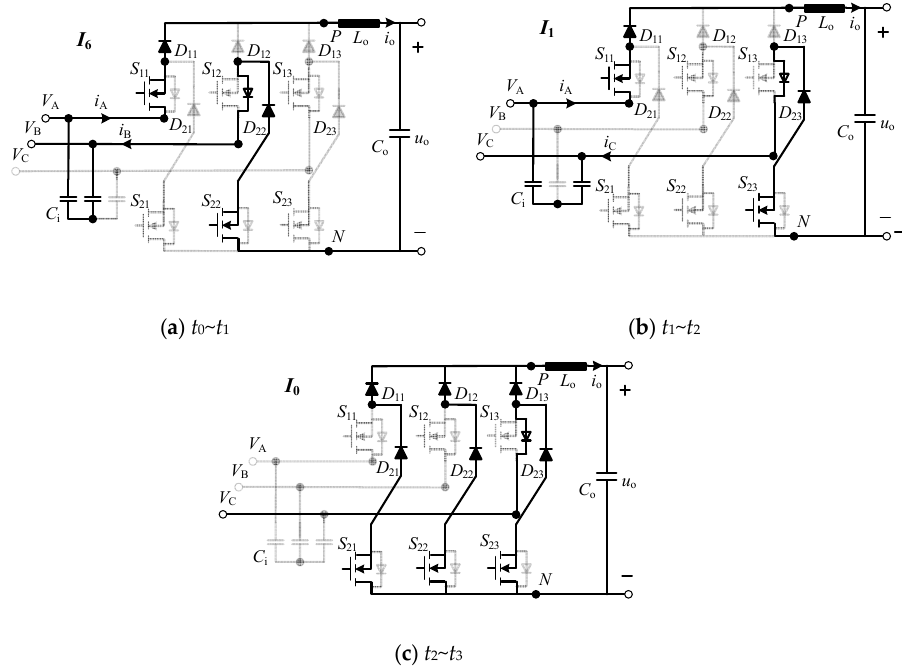
Figure 5. Switching states of the proposed CSR in sector 1. ( a ) Mode 1. ( b ) Mode 2. ( c ) Mode 3.